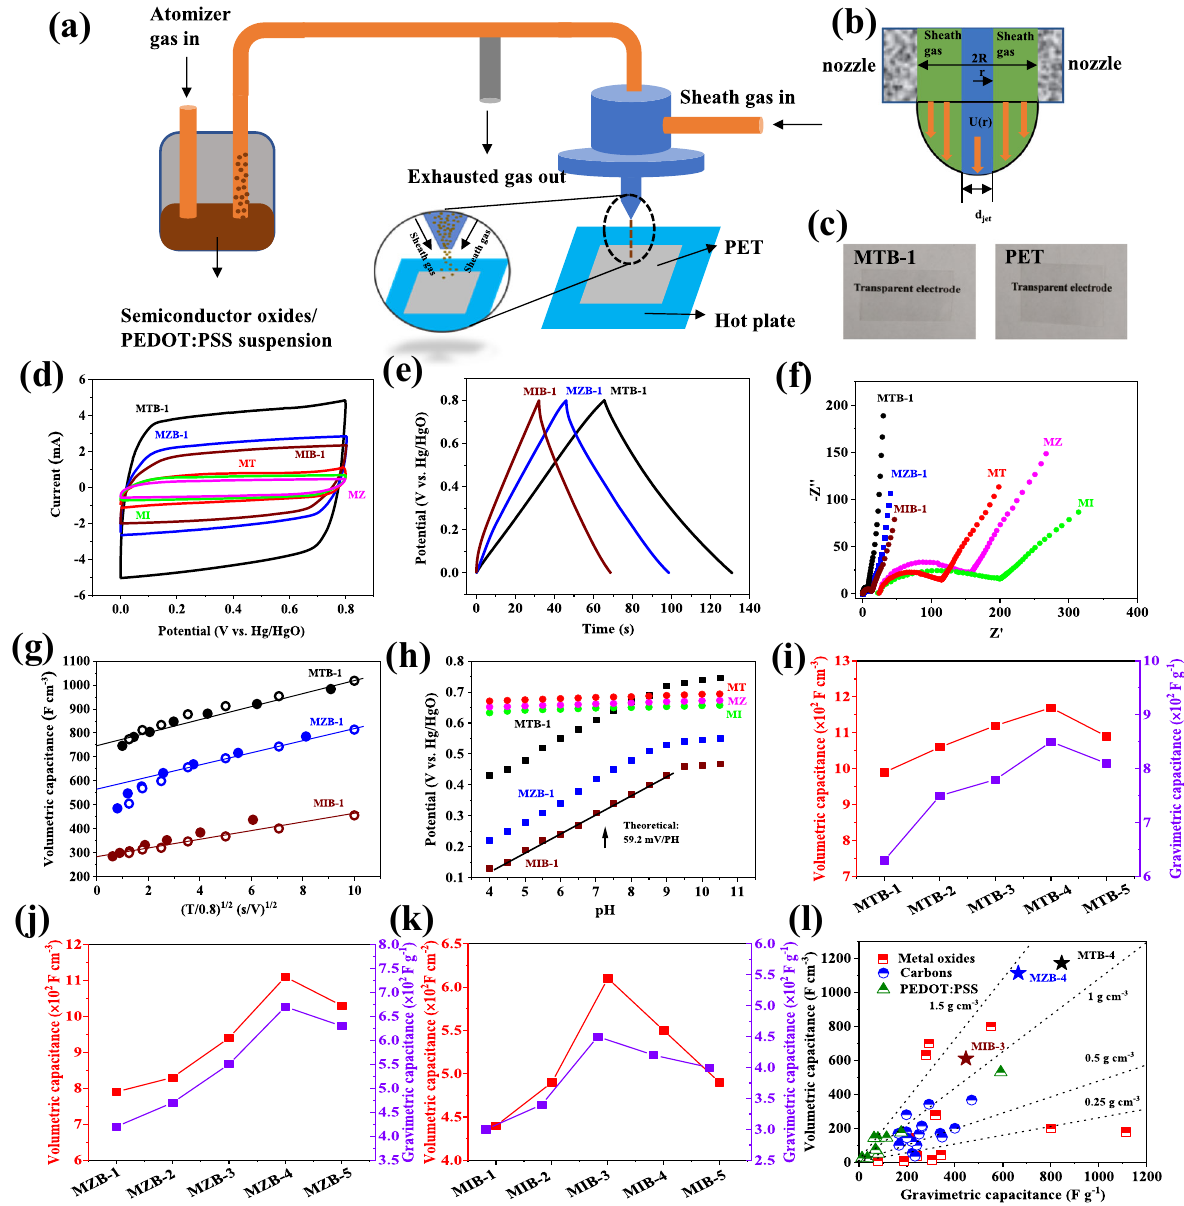
Fig. 3 Fabrication and electrochemical evaluation of transparent electrodes. a , b Schematic representation of aerosol-jet spraying technology and fl ow pro fi le inside a nozzle 23 . c Photographs of the transparent electrode. d – f Cyclic voltammetry (0.05V s − 1 , d ), galvanostatic charge/discharge (0.1 mAcm − 2 , e ), and Nyquist plots ( f ) for B-doped and undoped samples. g Capacity along with square root of half-cycle time for B-doped samples from CV (solid circles, 0.01 – 0.64V s − 1 ) and CC data (open circles, 0.1 – 6.4mAcm − 2 ). h Tafel plots of potential with pH value at steady-state current density of 10mAcm − 2 for B- doped and undoped samples. i – k Optimization of C vol and C gra in B-doped samples at 0.1 mAcm − 2 . l C vol and C gra of MTB-4, MZB-4, MIB-3 compared with carbon 24 – 41 , metal oxides 8,42 – 52 , and PEDOT:PSS 53 – 61